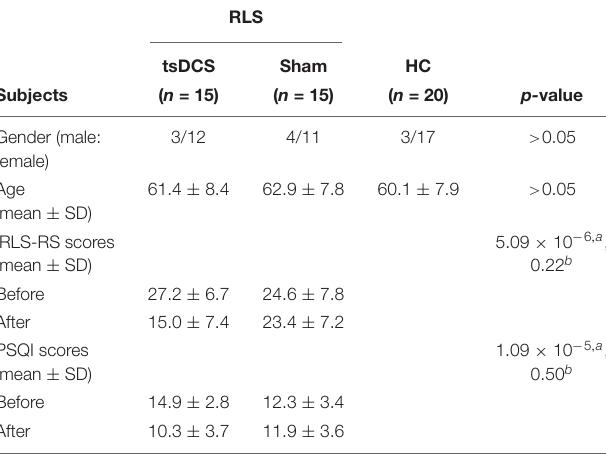
TABLE 1 | Demographics and clinical characteristics of the subjects used in present